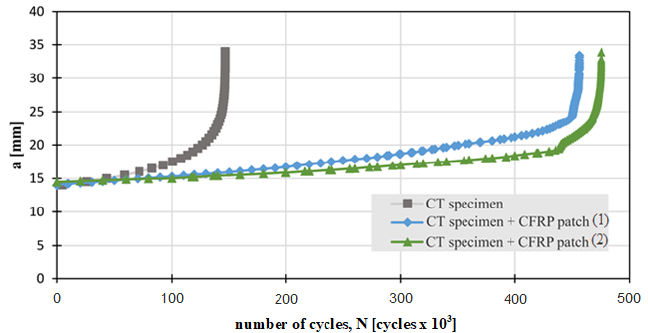
Figure 17. Crack growth evolution for strengthened and non-strengthened solutions ( R = 0.1 and F max = 7500 N).